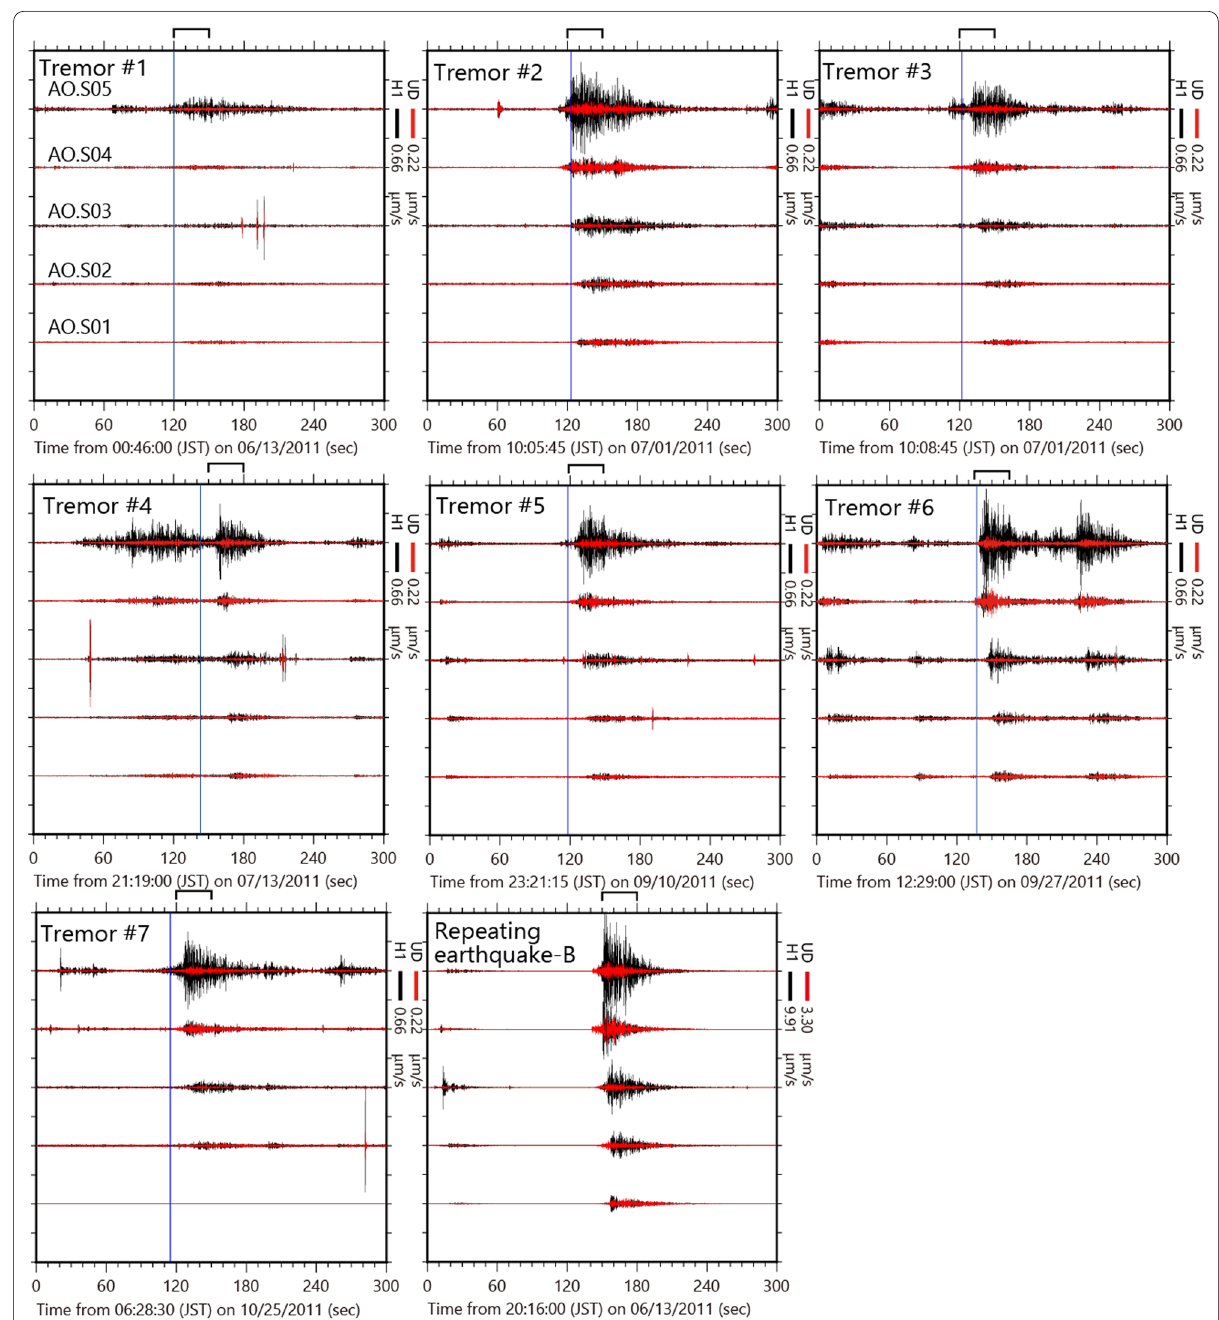
Fig. 3 Waveforms of tremor #1–7 and repeating earthquake-B. Filtered (2–4 Hz) horizontal and vertical seismograms with detected time-windows. The vertical blue line shows the origin time of the VLFE (Matsuzawa et al.